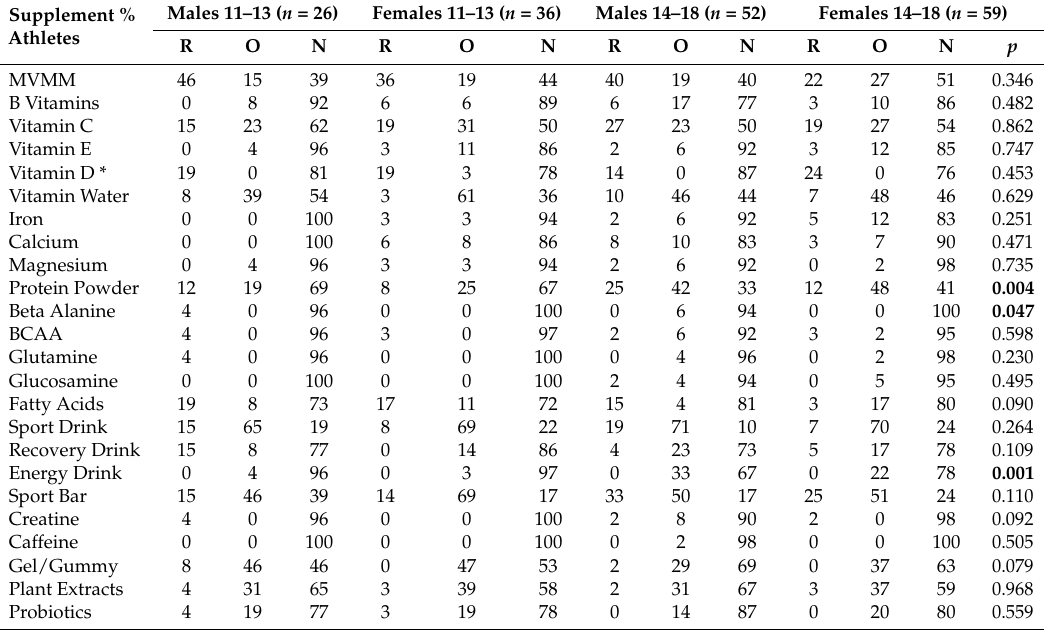
Table 5. Dietary supplements and ergogenic